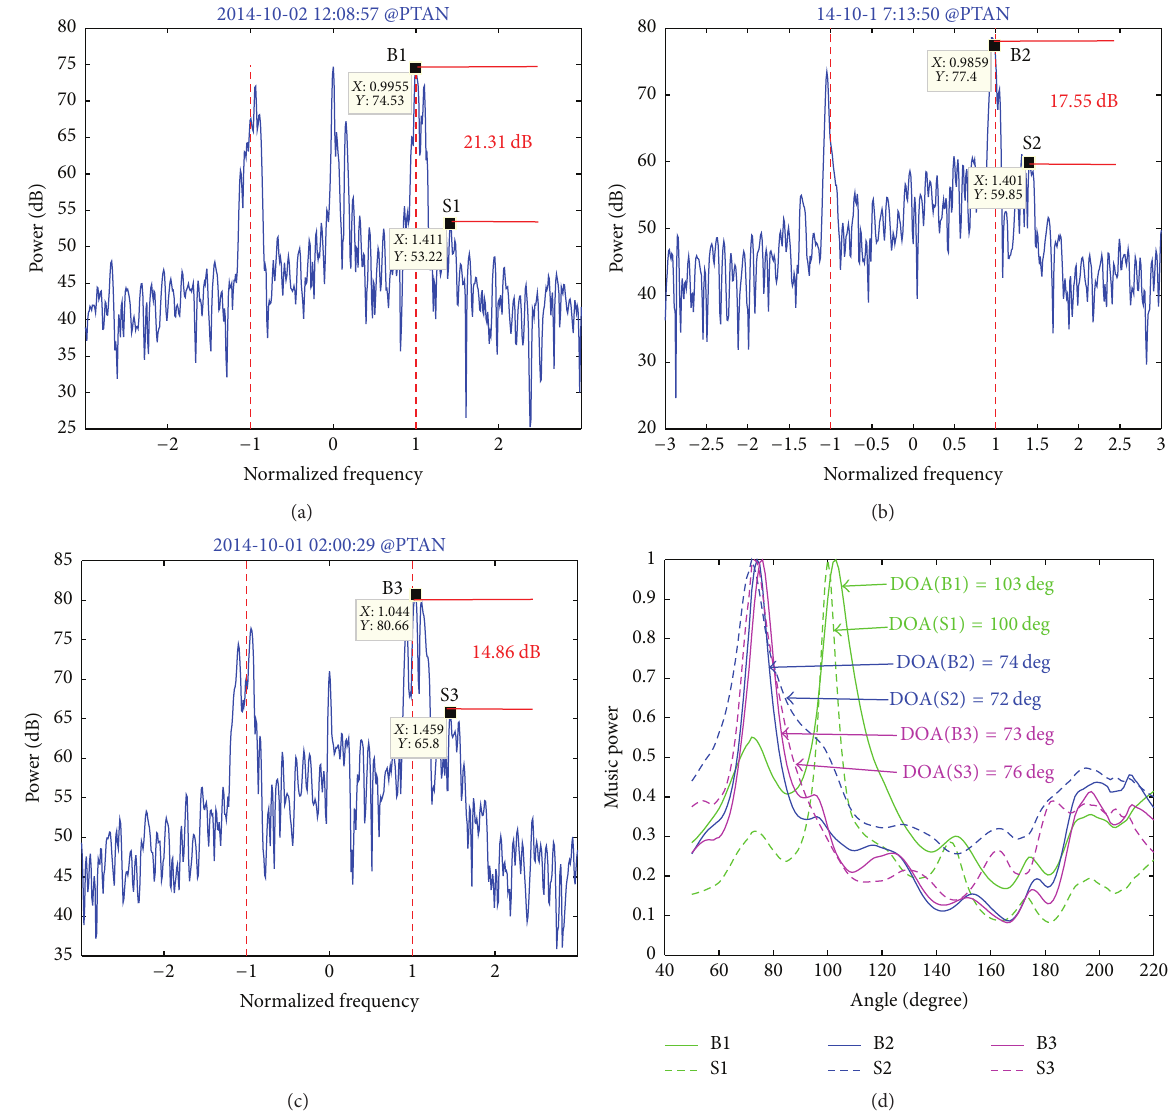
Figure 2: Observations of the RSB under different sea state, (a) the low sea state, (b) the normal sea state, (c) the high sea state, and (d) DOAs of the Bragg peaks and corresponding SHPs, estimated with